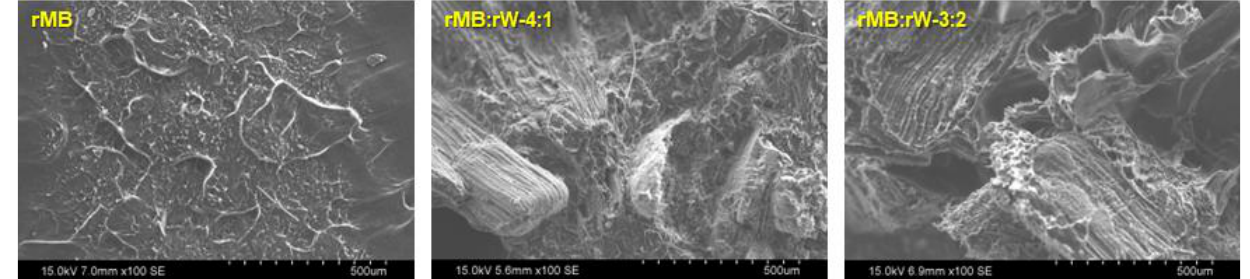
Figure 6. Scanning electron microscopy (SEM) of the impact test fracture surface of the injection- molded parts.